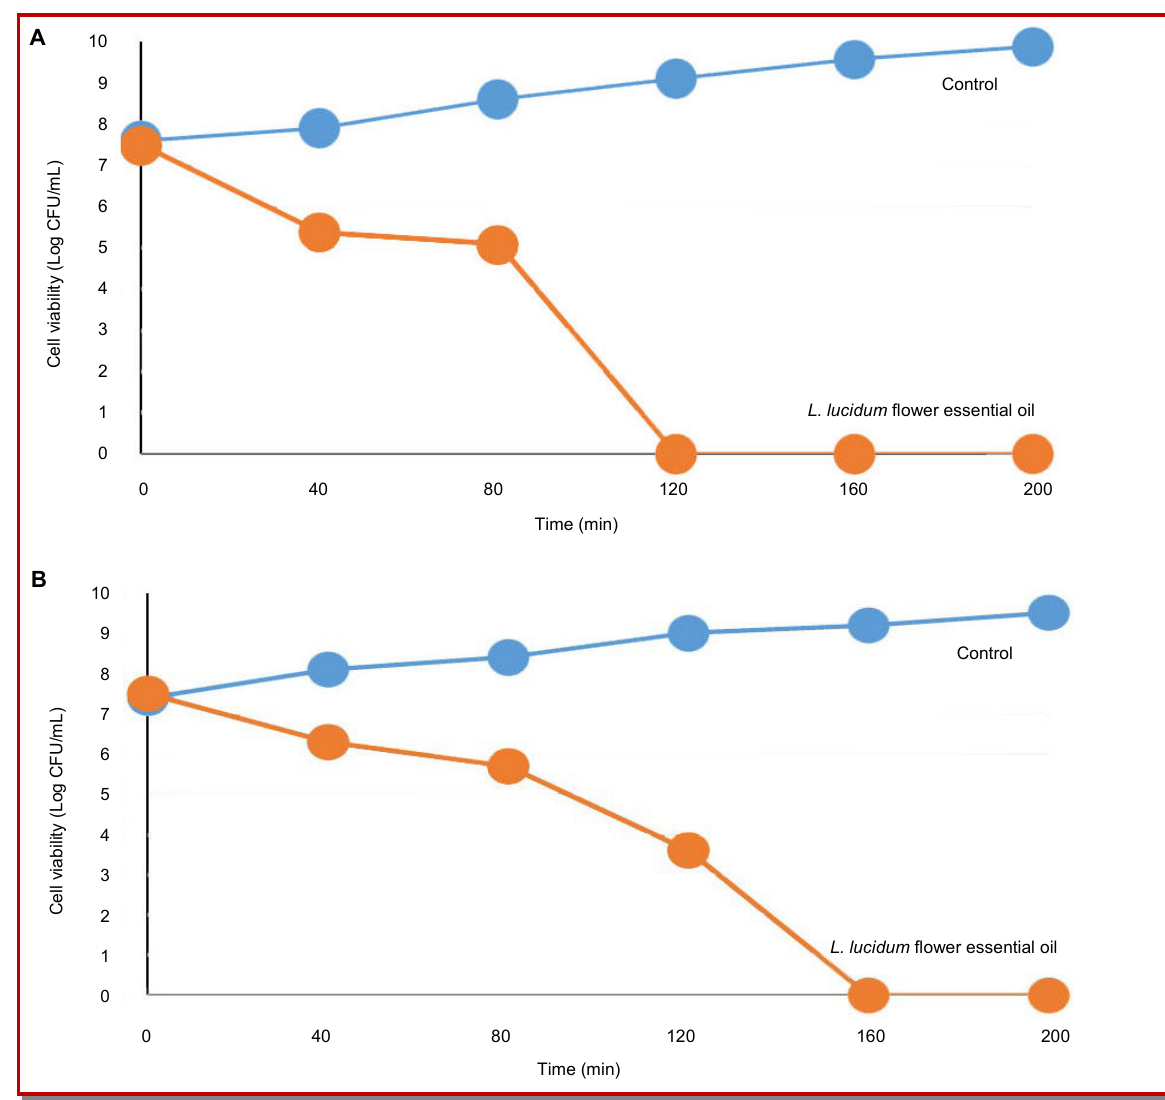
Figure 1: Effect of flower essential oil of Ligustrum lucidum on the viability of the tested pathogenic bacteria of S. aureus KCTC- 1621 (A) and S. enterica ATCC-4731 (B). CT: control without treatment. Data are expressed as mean ± SD (n =